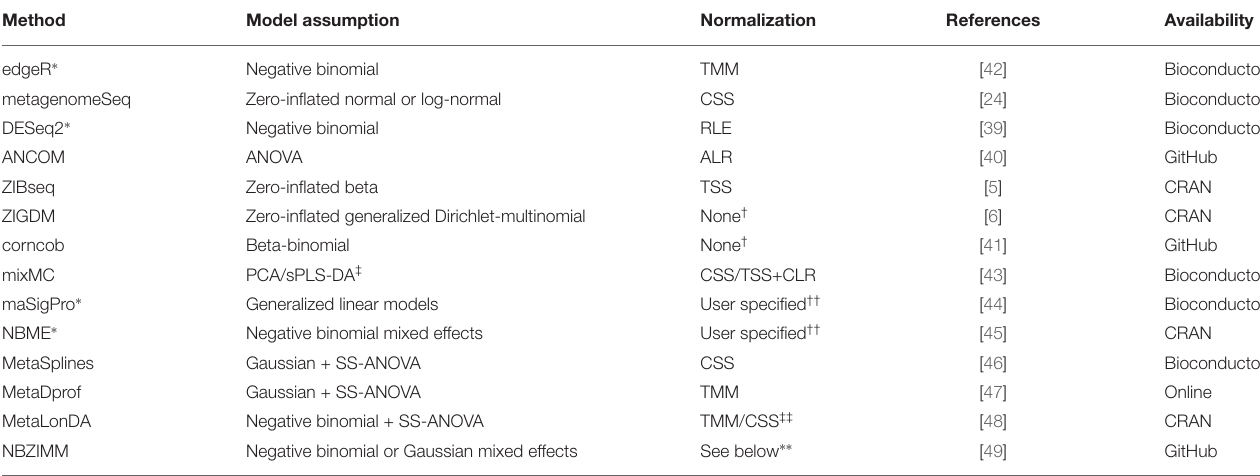
TABLE 3 | Summary of methods for differential abundance analysis in microbiome